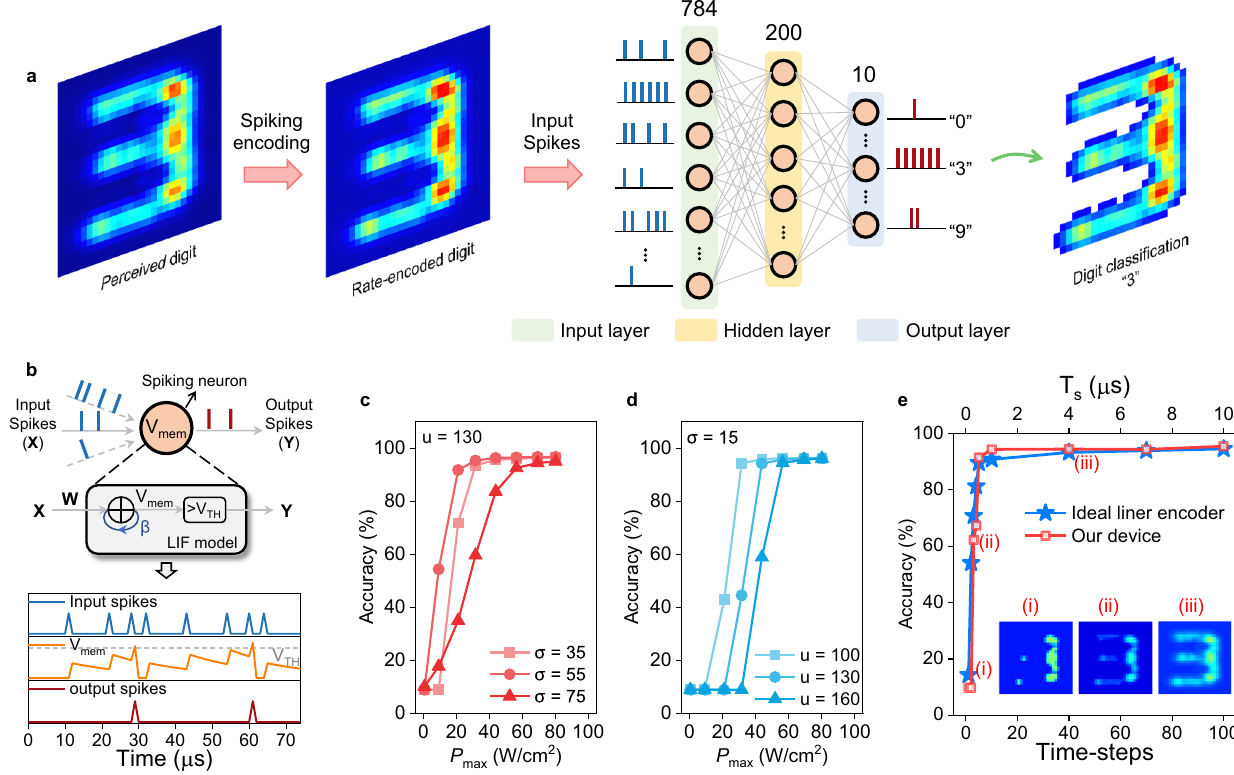
Fig. 4 | Digit encoding and classi fi cation by the 2D MIR optoelectronic retina and SNN. a The MIR digit image is detected and rate-based encoded into several series of spike trains which enter a trained fully-connected SNN to realize digit classi fi cationtask.Thecorrespondingdigitoftheoutputneuronhavingthehighest spikerate isthe predicted result. b The leakyintegrate-and- fi re(LIF)neuronmodel used in each nodes of SNN. The membrane voltage ( V mem ) increases with the weightedinputspikes( W (cid:1) X )untilitreachesaconstantthreshold( V TH )atwhichan output spike appears in the output spike train ( Y ) and the V mem is reset to zero. During the period without input spike, the V mem decays with the membrane